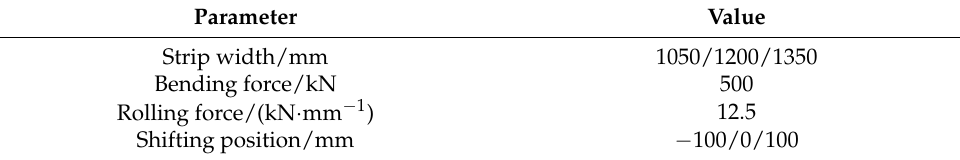
Table 4. Simulation condition for analyzing the influence of shifting on strip crown.